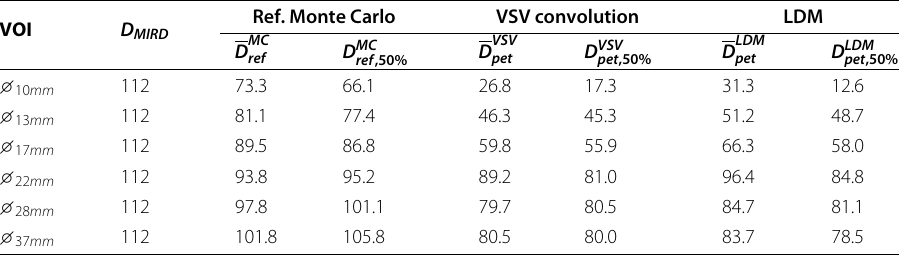
Table 4 Comparison between absorbed dose estimations for all spheres ( (cid:2) imm ). Reconstructions were performed using i3s10-2mm. All values in the table are in Gy D MIRD